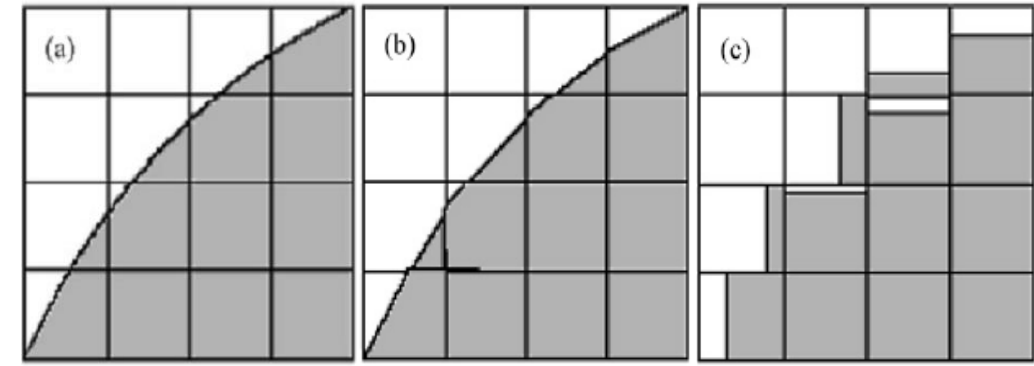
Fig. 2. (a) Actual interface shape (b) interface shape represented by the Geometric reconstruction scheme (c) interface shape represented by the donor-acceptor scheme (Fluent,